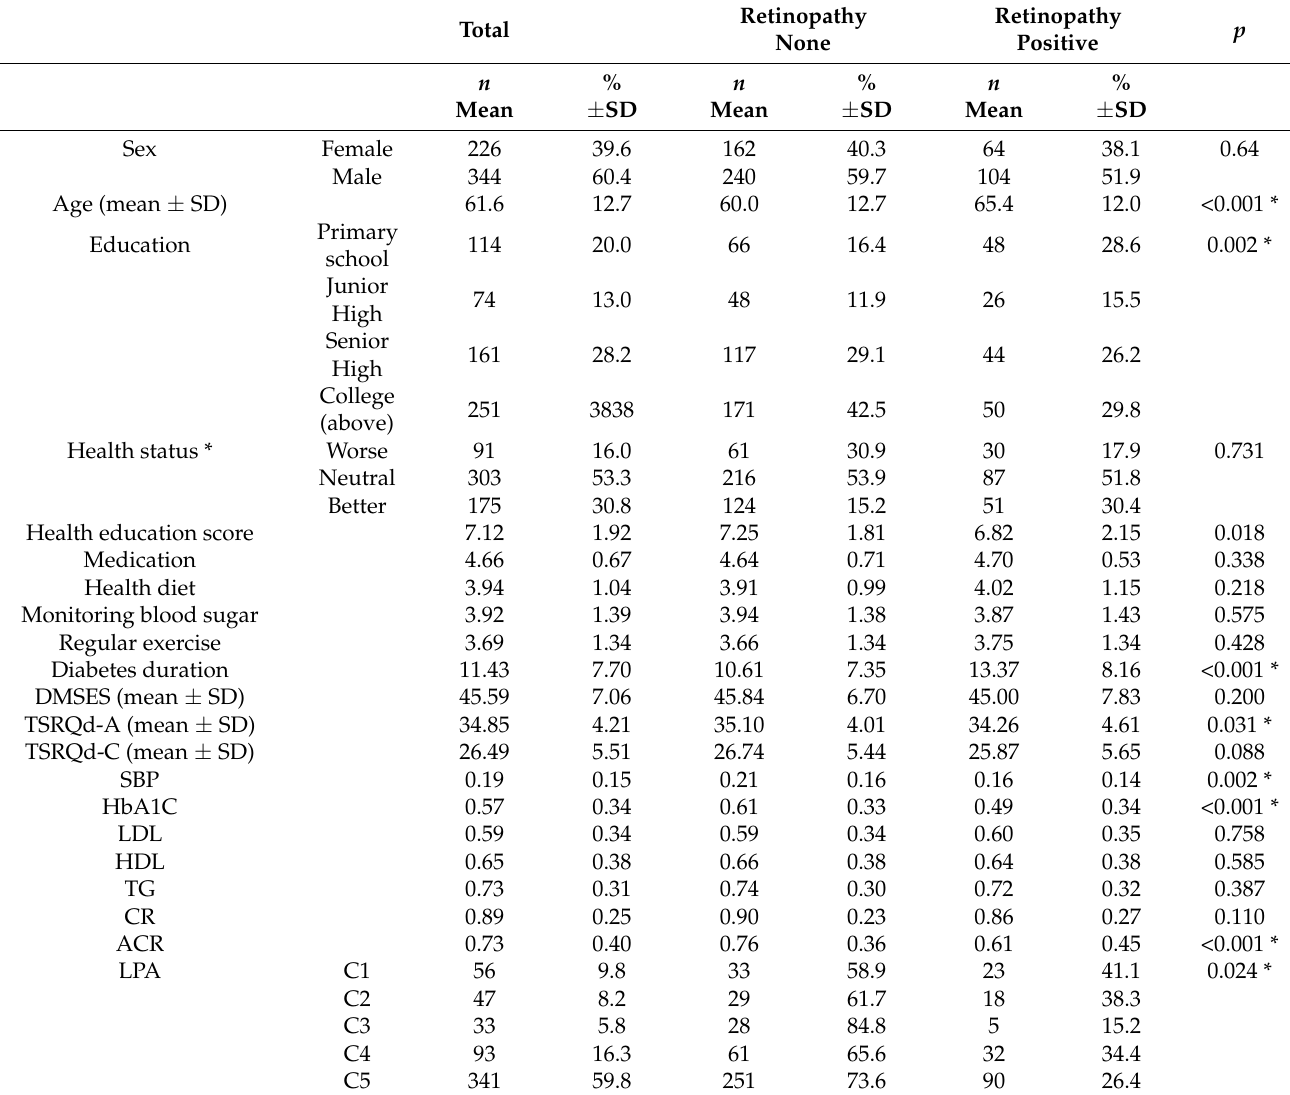
Table 2. The basic characteristics of subjects and items response distribution between whether retinopathy events occurred ( n =